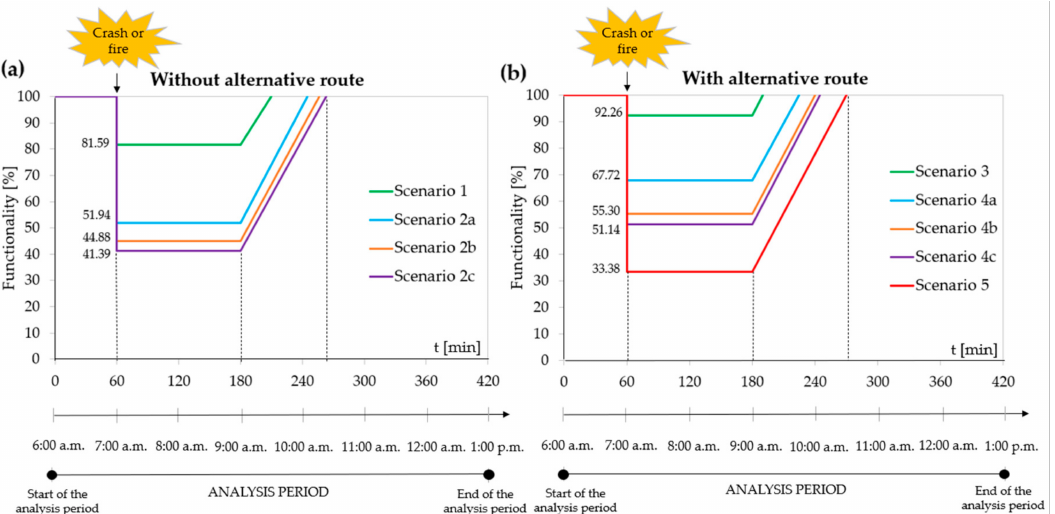
Figure 8. Functionality recovery curve of both the motorway section containing the tunnel tube investigated and the corresponding road network for the partial or complete closure of the north tube equal to 2 h: ( a ) without alternative route, ( b ) with alternative route. Scenario 1: partial closure of the north tube (only one lane is closed); Scenario 2: complete closure of the north tube and use of the adjacent one for bi-directional traffic with the traffic by-pass opening within 10 min (Scenario 2a), 20 min (Scenario 2b), and 30 min (Scenario 2c), respectively; Scenario 3: partial closure of the north tube with alternative itinerary used by HGVs only; Scenario 4: complete closure of the north tube and use of the adjacent one for bi-directional traffic with alternative itinerary used by HGVs only, and traffic by-pass opening within 10 min (Scenario 4a), 20 min (Scenario 4b), and 30 min (Scenario 4c), respectively; Scenario 5: complete closure of the north tube with alternative itinerary used by all the vehicles.